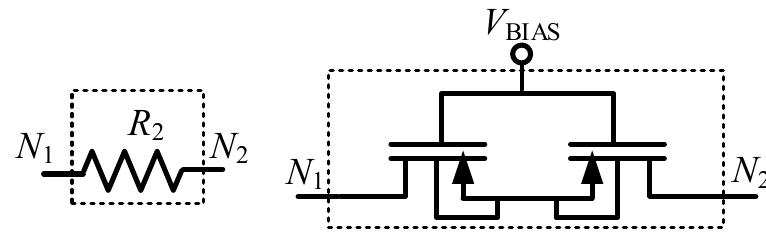
Figure 3. R 2 implemented with two pMOS transistors biased in subthreshold.